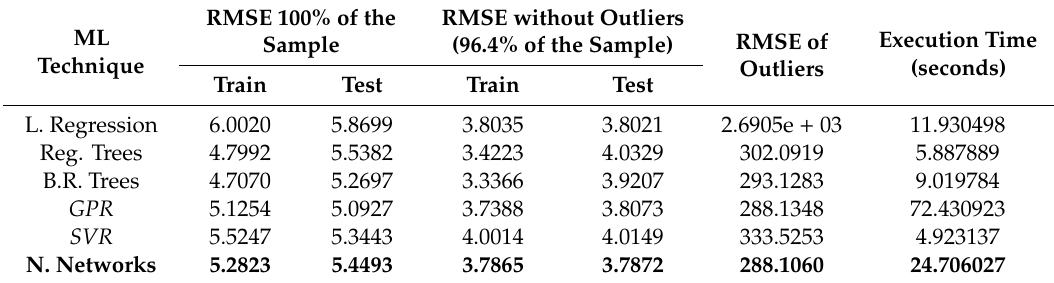
Table 10. BMI-CTDI VOL results for men’s Thorax protocol.